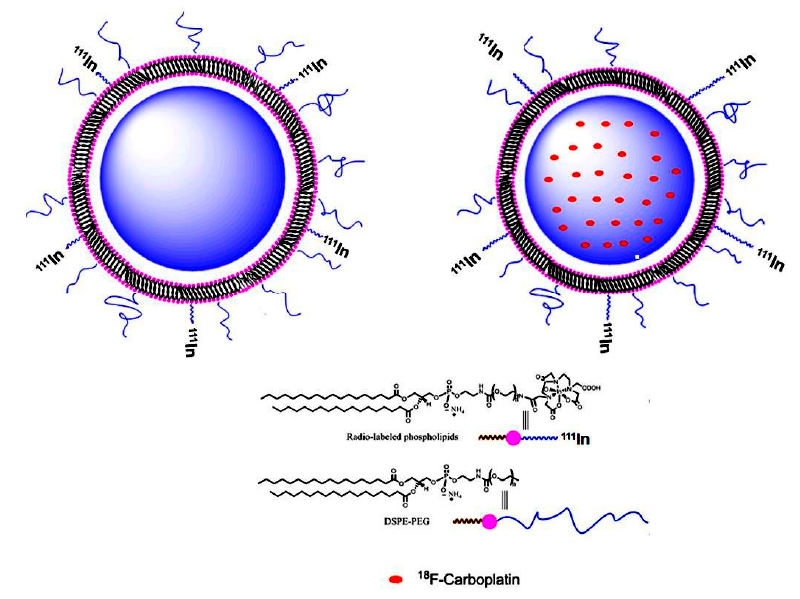
Figure 1. Schematics showing [ 111 In]-Liposome and its components along with encapsulated [ 18 F]-Carboplatin; DSPE-PEG: 1,2-distearoyl- sn -glycero-3-phosphoethanol-amine- N -[methoxy(polyethyleneglycol)] ammonium salt.